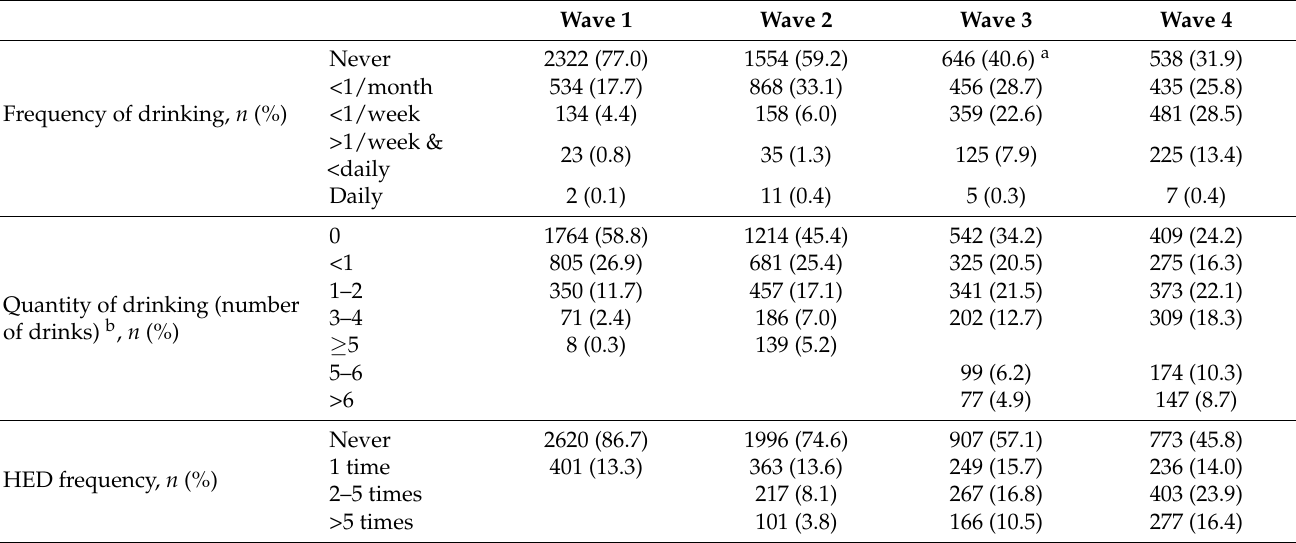
Table 3. Frequency and quantity of drinking and heavy episodic drinking (HED) over data collec- tion waves.